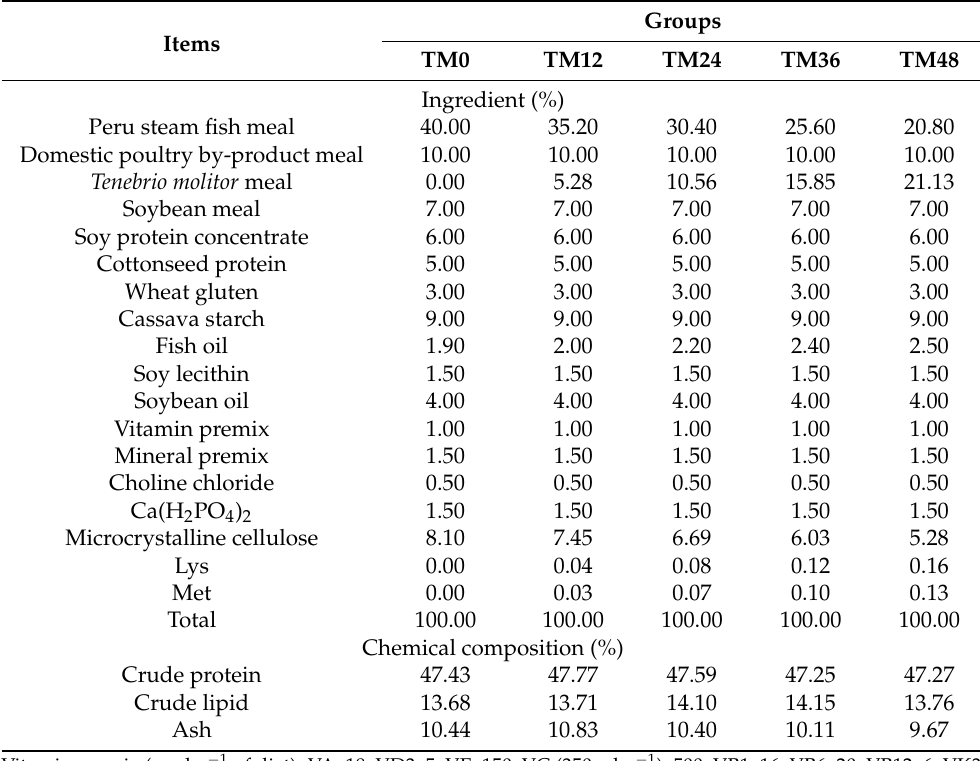
Table 2. Composition and nutrient levels of experimental diets (DM